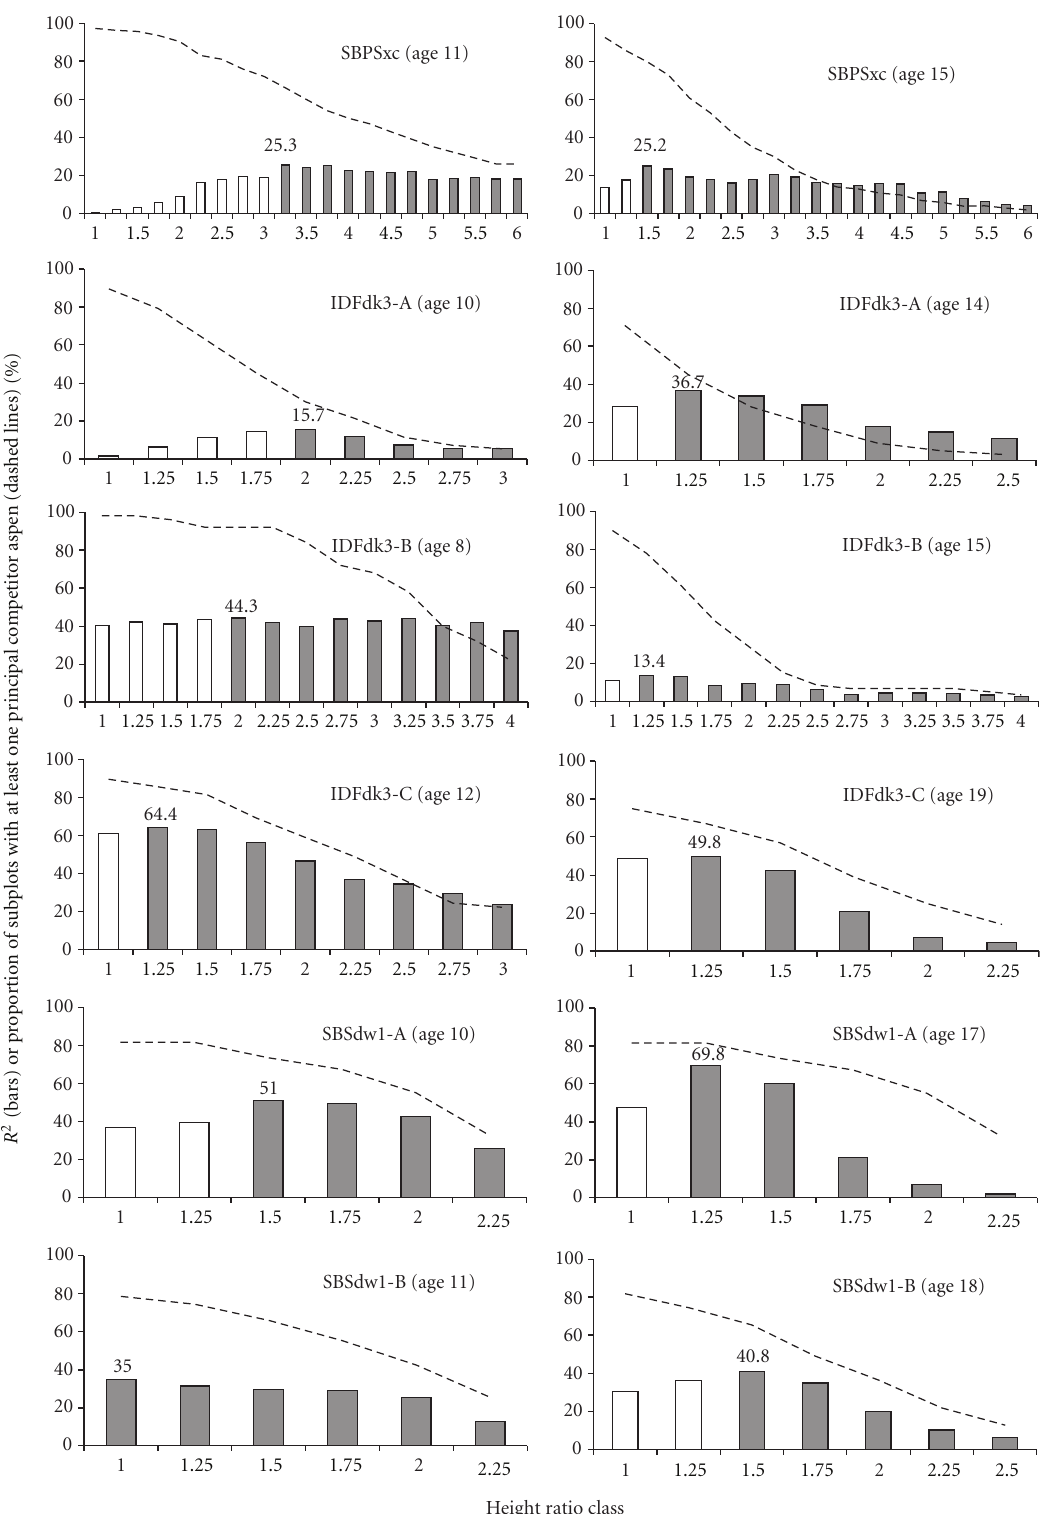
Figure 1: R 2 for predicting 2–5-year pine diameter growth (bars) and the proportion of subplots having at least one aspen stem (lines) for each aspen/pine HR class, at two stand ages at each of the six study sites. CHR is the lowest HR class designated by a gray bar. Analysis was conducted in a downward manner, so the analysis for a given class includes aspen in that class and all HR classes above